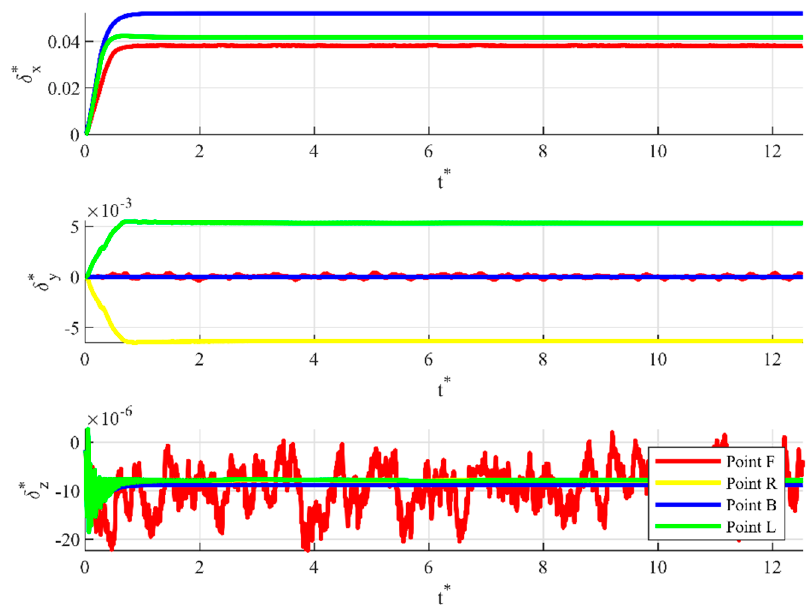
Figure 3. Displacements at the four reference mid-height nodes (points F, B, R, and L in Figure 1) in the flow direction (top panel), cross-flow direction (middle panel) and vertical direction (bottom panel), for the steady current test.